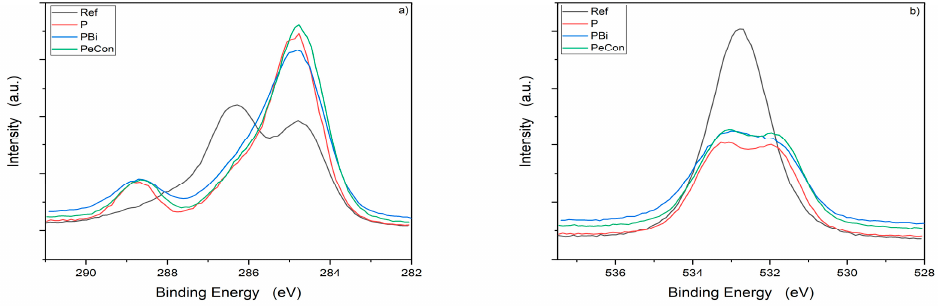
Figure 3. X-ray photoelectron spectroscopy (XPS) detail spectra of reference, polyester and CSs coated beech carbon ( a ) and oxygen ( b ).